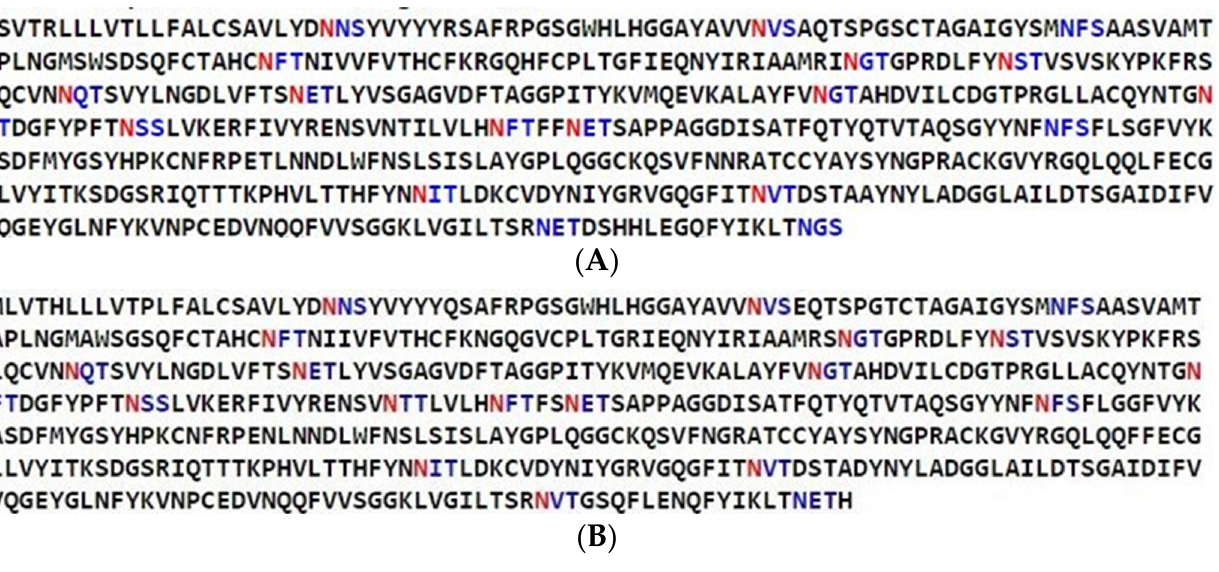
Figure 2. The sequons Asn-X-Ser/Thr in the S1 glycoprotein of IBV/Ck/Can/2558004 ( A ) and MDL_DMV1639 _15-5582 (KX529725) ( B ). Asn-Xaa-Ser/Thr sequons in the sequences are high- lighted in blue. Sequons predicted to be N-glycosylated by NetNglyc server are shown in red.